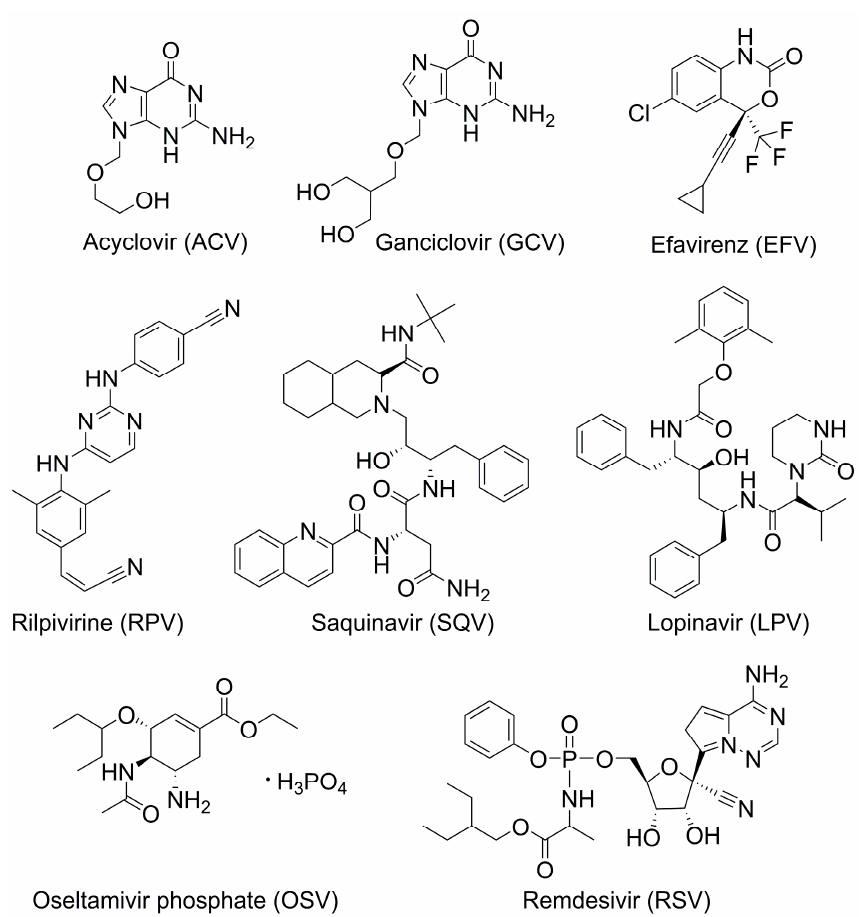
Figure 3. Commercially available antiviral active pharmaceutical ingredients (APIs) reported to form inclusion complexes and/or interaction products with native and chemically modified cyclodextrins.